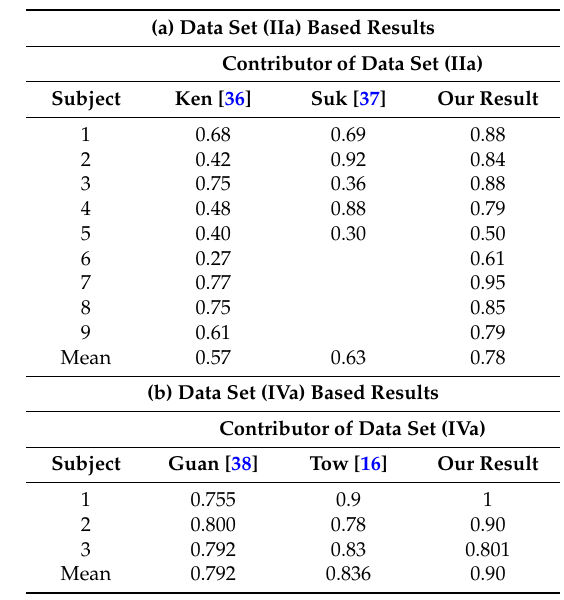
Table 10. A comparison between BCI competition and our